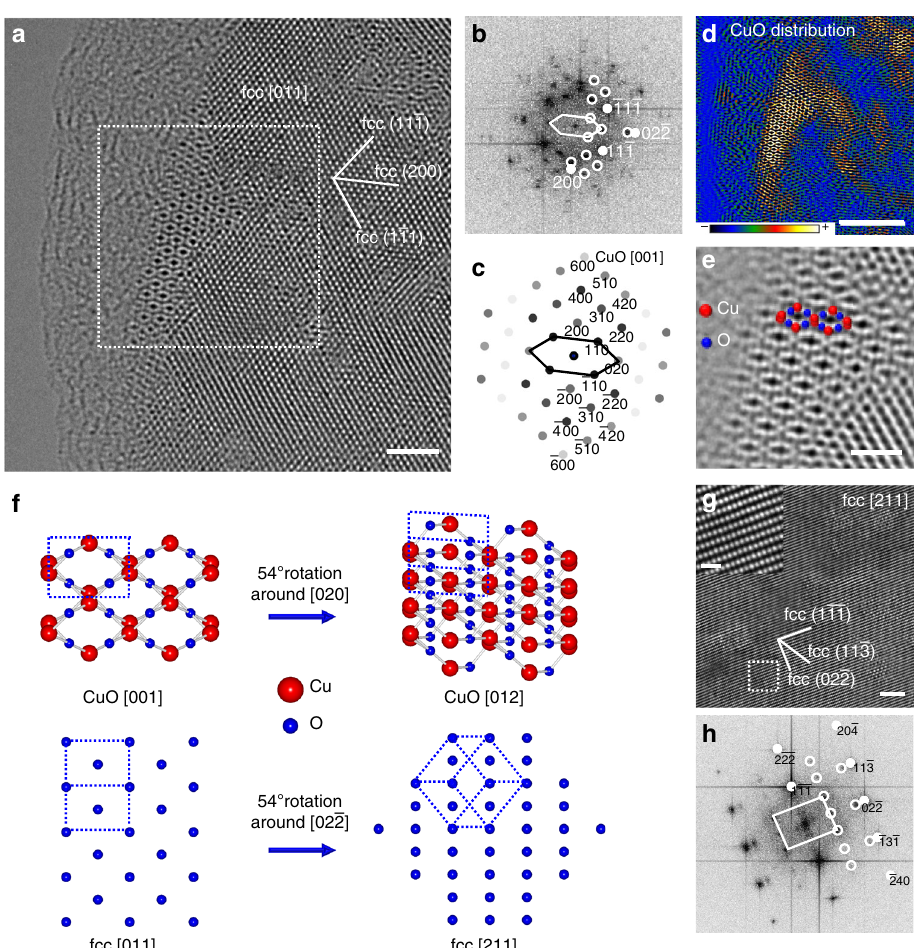
Fig. 4 Lattice matching relationship between CuO and fcc matrix. a HRTEM image of CuO developed from fcc matrix with [011] fcc zone axis. b FFT image calculated from the white frame area in a . c Simulated diffraction pattern of CuO on zone axis of [001] CuO . d CuO distribution generated from the CuO re fl ections marked with white circles in b . e Enlarged fi ltered CuO HRTEM image. f Schematic illustration of lattice matching relationship between CuO and fcc matrix. g HRTEM of fcc matrix on zone axis of [211] fcc . The inset is an enlarged area of fcc matrix. h FFT re fl ections of image ( g ). Scale bar: ( a ) 2 nm, ( e ) 1 nm, ( g ) 2 nm and the inset in g 0.5